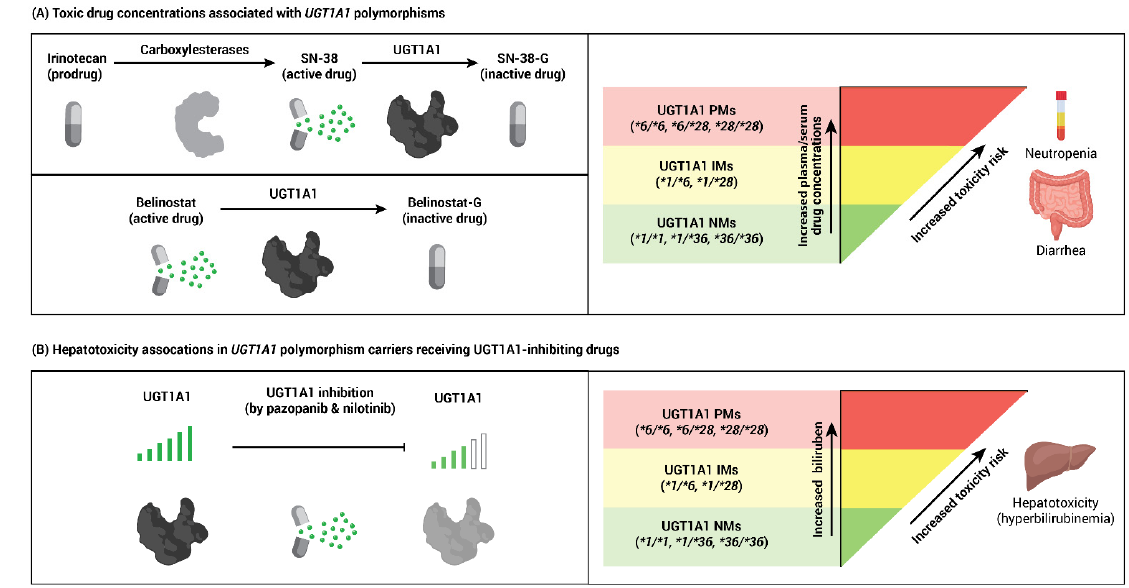
Figure 1. Association of UGT1A1 polymorphisms with toxicity from cancer drugs. ( A ) Irinotecan and belinostat are metabolized by UGT1A1. Intermediate (IM) or poor (PM) UGT1A1 metabolic activity may result in greater than expected exposure to SN-38 (the active drug metabolite of irinotecan) and belinostat, increasing the risk of neutropenia or diarrhea. ( B ) The tyrosine kinase inhibitors pazopanib and nilotinib can inhibit UGT1A1 enzyme function, which may lead to an increased incidence of hyperbilirubinemia in UGT1A1 IMs or PMs.